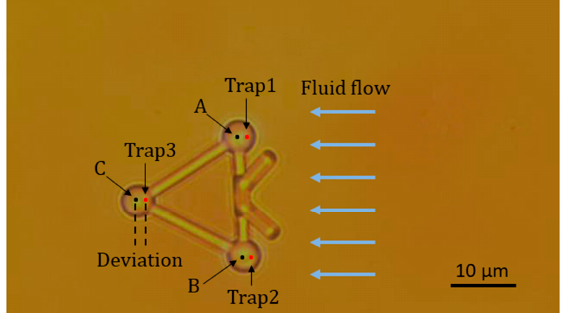
Figure 7. Microtool in three optical traps and fluid flows.